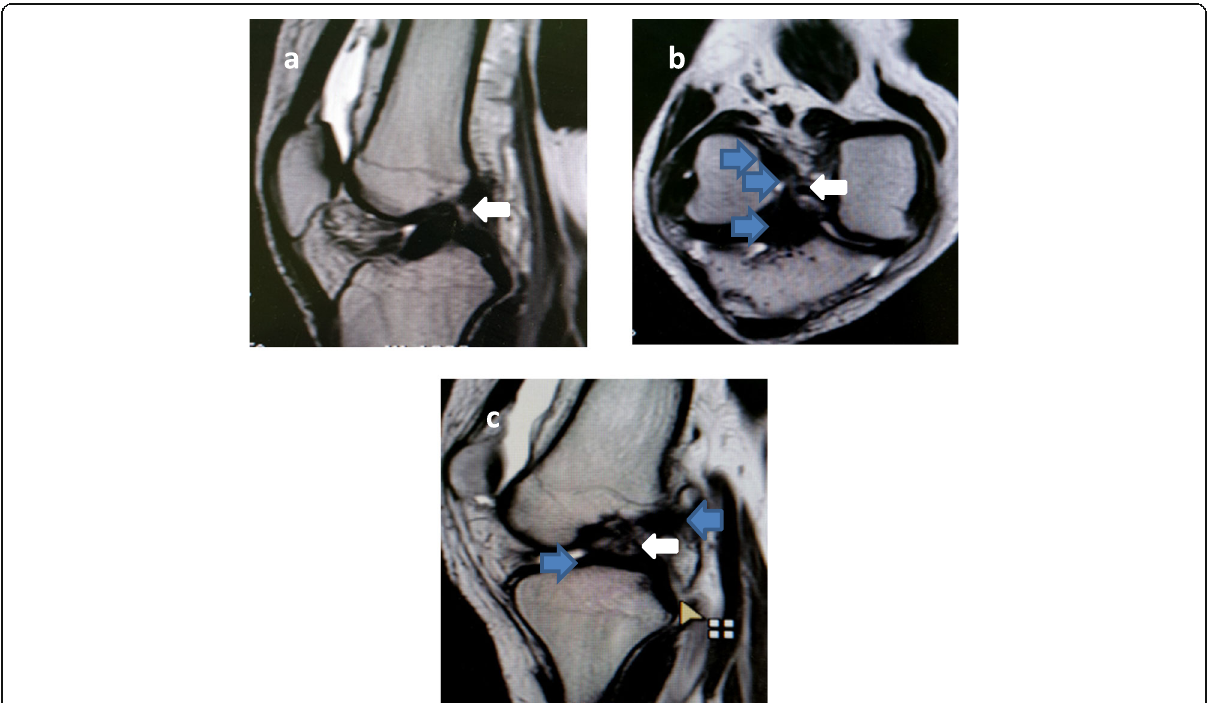
Fig. 5 A male patient, 43 years old, complaining of knee trauma after a rotational knee injury during playing basketball. a Orthogonal sagittal T2 image revealing a complete thickness tear near the femoral attachment of the ACL. b Oblique coronal T2 and c oblique sagittal MRI images showing abnormal bright signal intensity at the ACL mid-substance confirming the complete ACL thickness tear with better delineation of the mild retraction of the femoral and tibial attachments